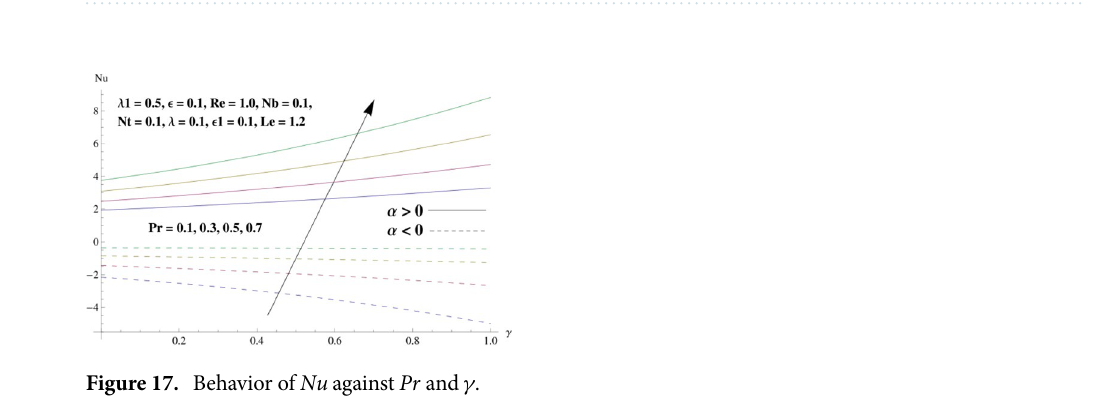
Figure 16. Behavior of C f against Re and (cid:31) .